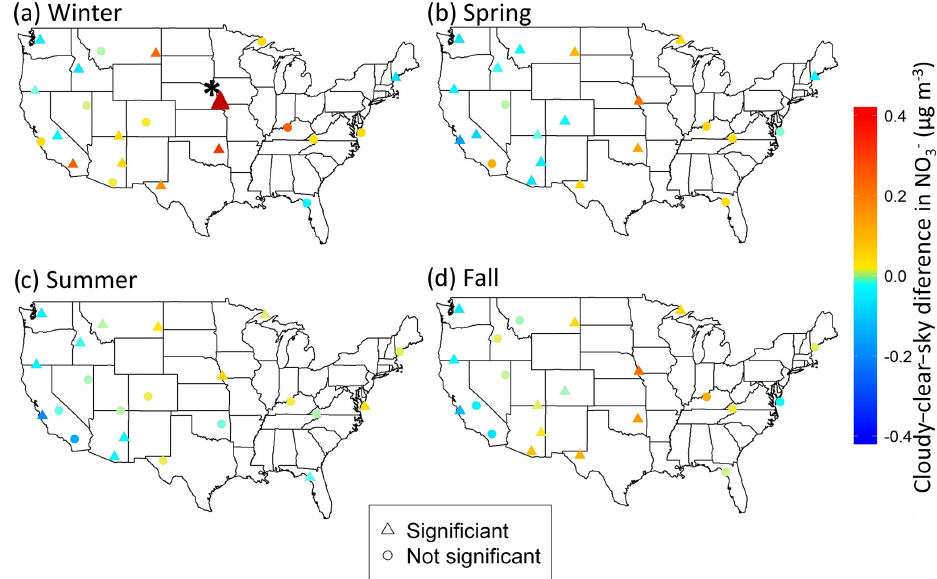
Figure A3. Maps of the difference in NO − mass concentration medians (cloudy–clear-sky) for all regions from 2010 to 2014 for (a) winter, 3 (b) spring, (c) summer, and (d) fall. The color of the point corresponds to the magnitude of the difference. Triangles indicate that median differences are significant according to the Mann–Whitney U test. Note that the difference in medians for daily NO − for the Central Great Plains (denoted with asterisk) is substantially larger than other regions (the cloudy median value is 1.07µgm − 3 larger than clear-sky).